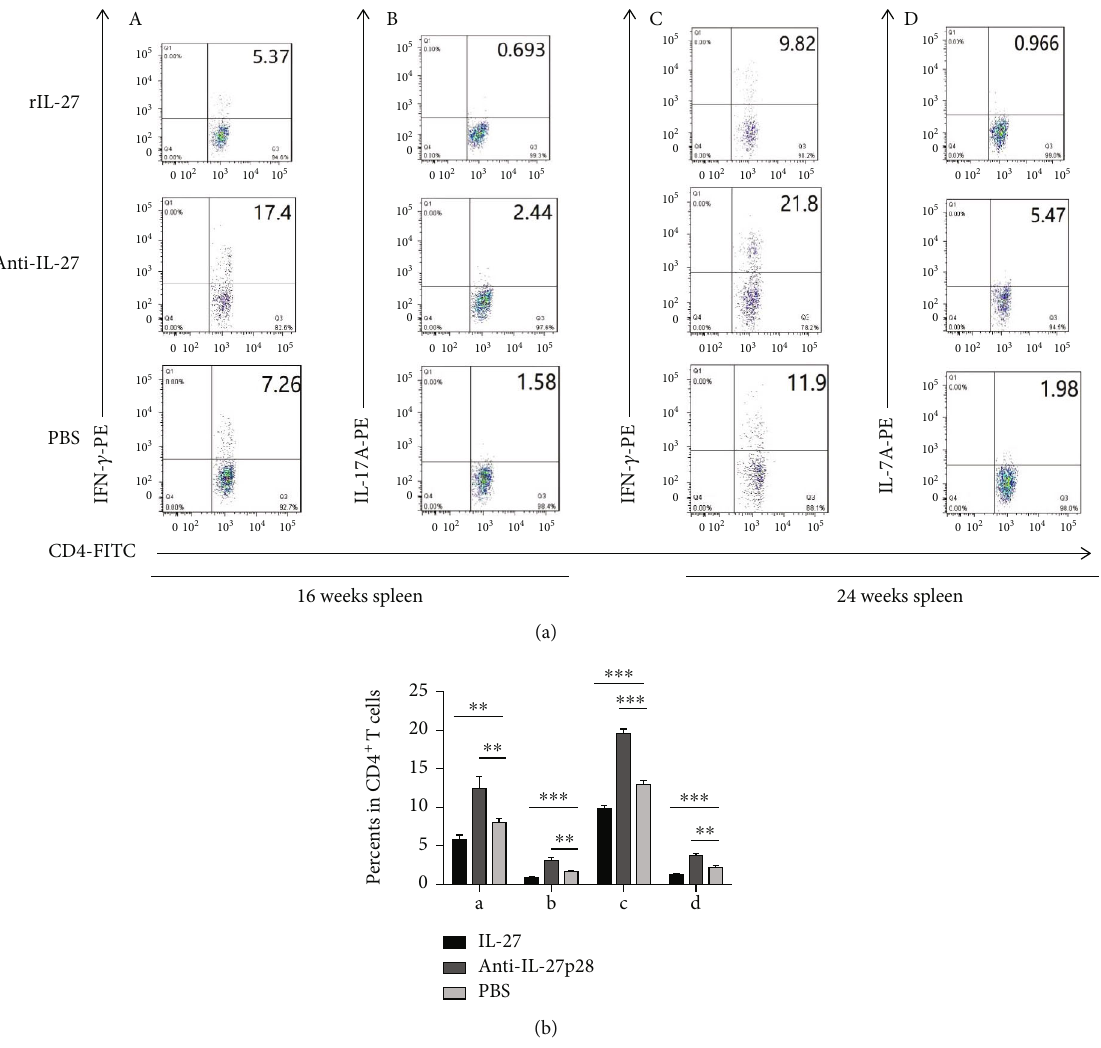
Figure 5: Recombinant IL-27 reduced the fractions of Th1 and Th17 cells in the spleen of ApoE -/- mice. (a) In the spleen, the fractions of Th1 and Th17 cells were measured by fl ow cytometry. (A) and (B) show the fractions of Th1 (A) and Th17 cells (B) during the initiation of atherosclerosis. (C) and (D) show the fractions of Th1 (C) and Th17 cells (D) during the progression of atherosclerosis. (b) Groups data are shown in histogram. ∗∗∗ P < 0 : 001 , ∗∗ P < 0 : 01 , ∗ P < 0 : 05